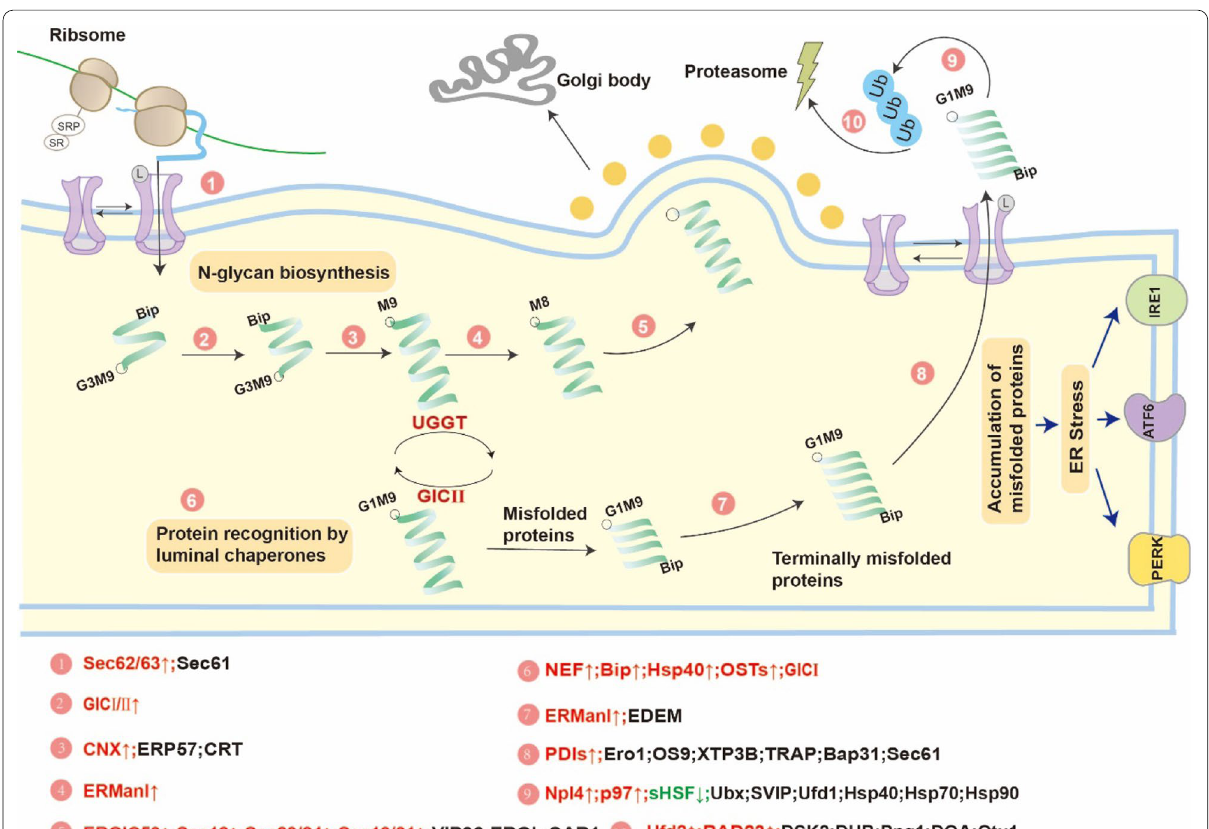
Fig. 6 Differential transcription of genes involved in protein processing in the endoplasmic reticulum (ER). With the KEGG annotation result for ER, we also performed pathway functional enrichment using phyper, a function of R. Then, we calculated the false discovery rate (FDR) for each p